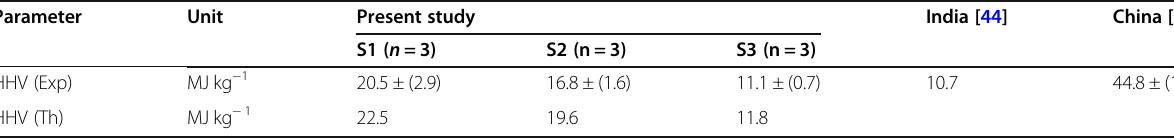
Value in parenthesis represent standard